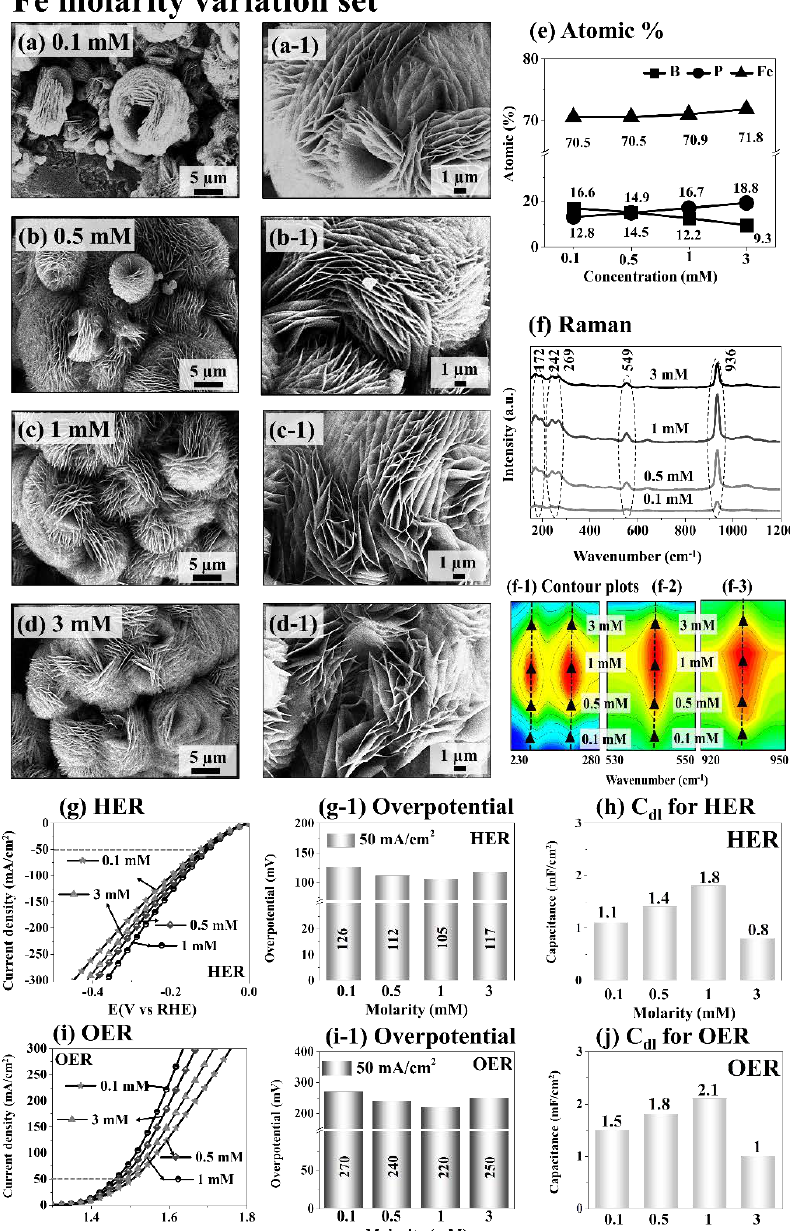
Figure 1. Fe concentration variation between 0.1~3 millimolar (mM) for the fabrication of FeBP MSC electrocatalysts at 100 °C for 12 h. A total of 20 mmol of CH 4 N 2 O, 6 mM NaH 2 PO 2 .H 2 O and 6 mM H 3 BO 3 were used. ( a )–( d ) SEM images of FeBP electrodes. ( a-1 )–( d-1 ) Magnified SEM micrographs. ( e ) Atomic% graph. ( f ) Raman spectra of FeBP. ( f-1 )–( f-3 ) Contour plots of Raman peaks. ( g , i ) LSV measurements in 1 M KOH. ( g-1 , i-1 ) Overpotential bar chart at 50 mA/cm 2 . ( h ) and ( j ) C dl values for HER and OER.